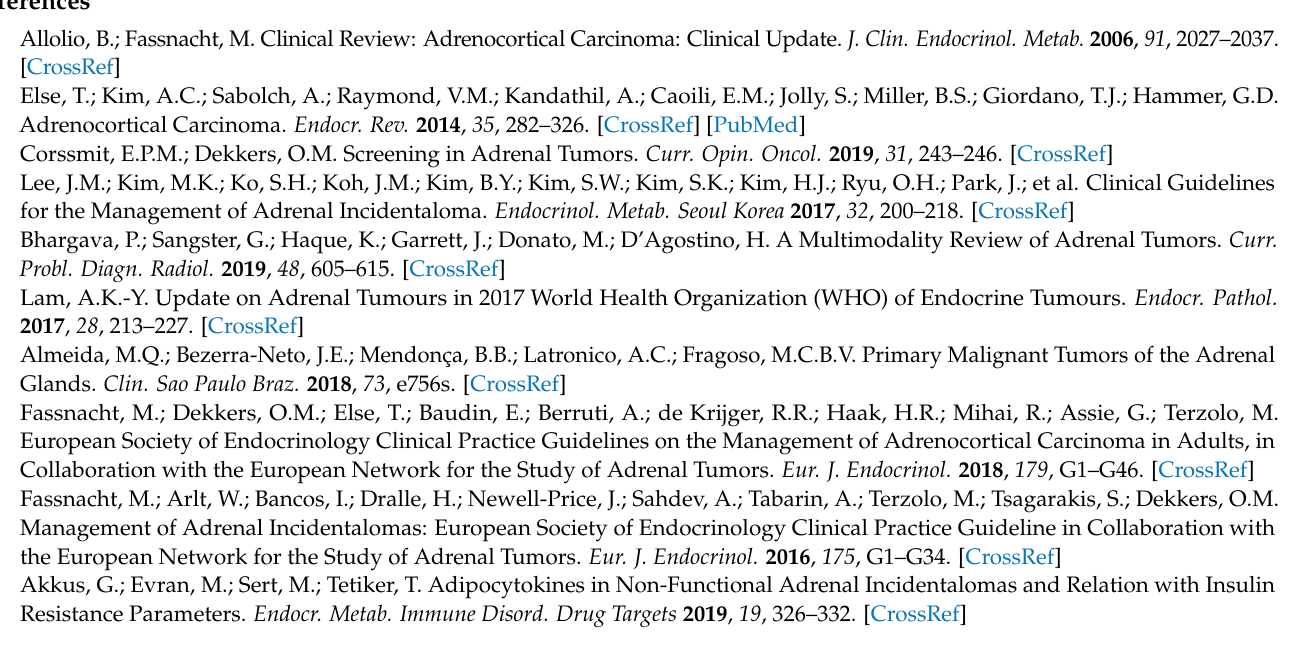
tumors; Table S2: Sample size analysis for ROC analysis with visfatin serum level as a predictor discriminating between patients with adrenocortical carcinomas and benign adrenocortical tumors; Figure S1: V-fold cross-validation—learning ROC curves for the univariate logistic regression model including visfatin serum